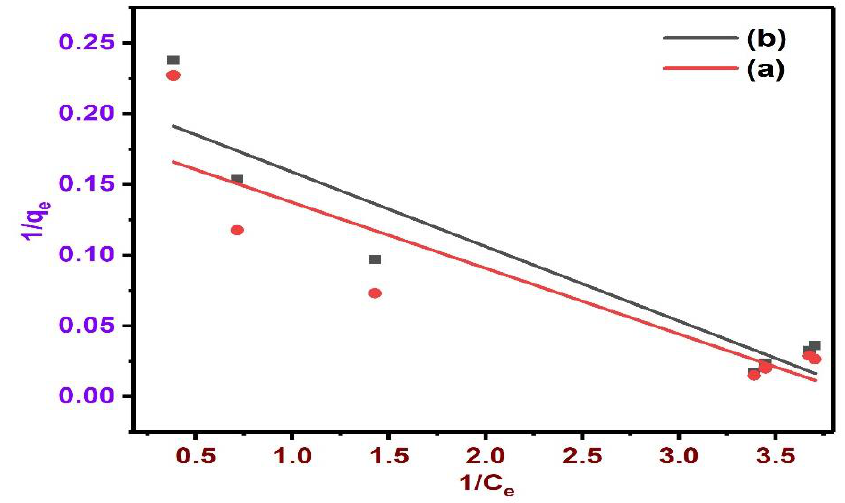
Figure 13. Langmuir isotherm on BPA adsorption onto NBC (a) and MBC (b) at 0.5 g dose, pH 6.0, contact time 240 min, and initial BPA concentration 50 ppm. Table 4. Adsorption Isotherms variables.